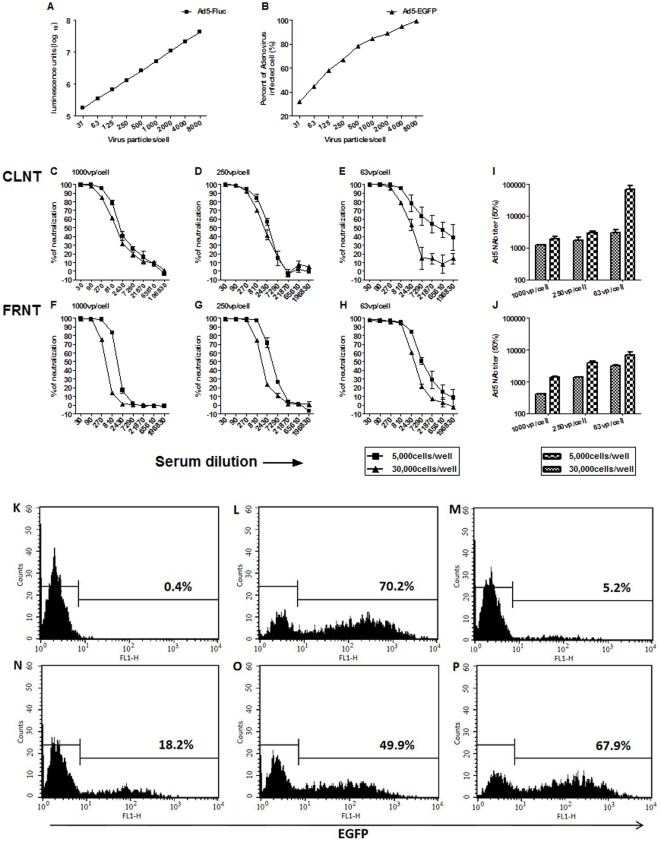
Optimization of conditions for CLNT and FRNT assays.(A) Dose-response between Ad5-Fluc virus inoculum and luciferase transgene expression. (B) Dose-response between Ad5-EGFP virus inoculum and percent of infected cells. The x-axis indicated virus concentration, ranging from 31–8000 VP/cell, added to 30,000 cells/well in a 96-well plate. Each data point represented the average of three experiments. (C–H) Different amounts of virus and cell density were used in the neutralization assay (▪, 5,000 cells/well; ▴, 30,000 cells/well), and the percentages of neutralization were shown for nine serial 3-fold dilutions of Ad5-vaccinated mouse serum, with CLNT (C–E) and FRNT (F–H) assays. Each data point represents the average of three experiments. (I–J) Ad5NAb titers determination with CLNT (I) and FRNT (J) assays. Each column represents the average of three experiments. (K–P) FACS analysis of Vero cells infected with Ad5-EGFP expressing the EGFP reporter gene. Incubation with optimized viral dose (250VP/cell) and cell density (30,000 cells/well) with a 810-fold (M), 2430-fold (N), 7290-fold (O), 21870-fold (P) dilutions of Ad5-vaccinated mouse serum or without serum (L) resulted in 5.2%, 18.2%, 49.9%, 67.9% or 70.2% EGFP-positive cells, respectively, and uninfected cell control (K) resulted in 0.4% EGFP-positive cells. The mean percentage of infected cells was shown in each plot. Representative data were shown for three independent experiments.